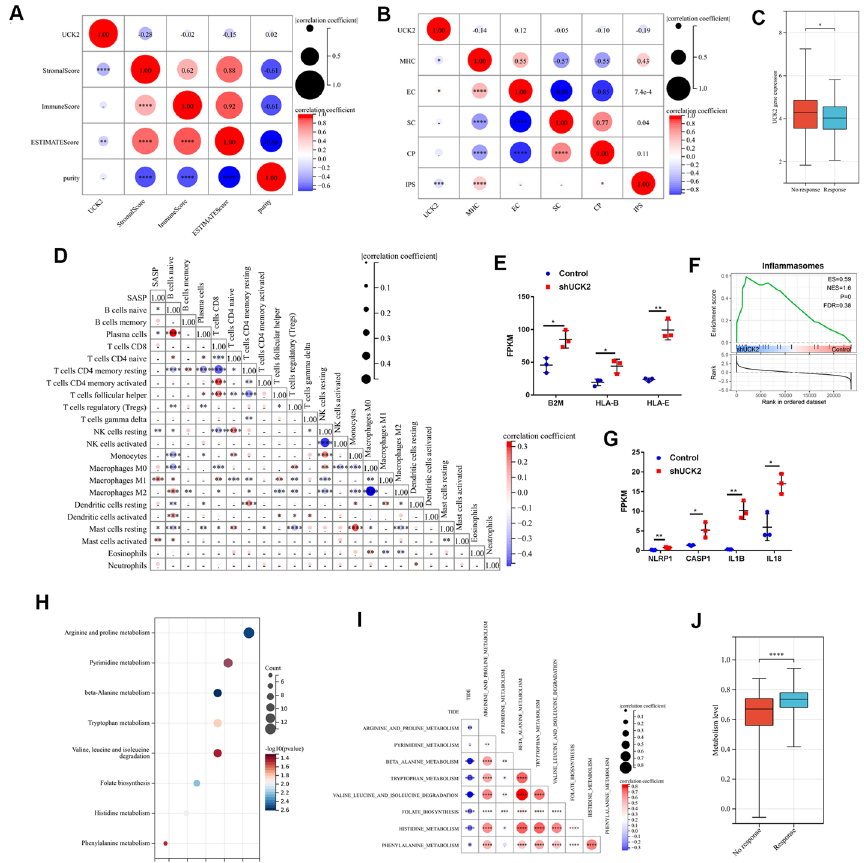
Fig. 7 Targeting UCK2 could enhance the sensitive of tumour cell to T-cell-mediated killing. A Correlation of UCK2 with ESTIMATE scores and tumour purity. B Correlation between UCK2 and IPS scores. C Gene expression of UCK2 in immunotherapeutic response versus non-response group from TIDE. D Correlation between SASP and immune cell infiltrating derived from CIBFERSORT. E Gene expression of B2M, HLA-B and HLA-E in the indicated cell lines. F GSEA revealed the level of inflammasomes in the indicated cell lines. G Gene expression of NLRP1, CASP1, IL1B and IL18 in the indicated cell lines. H Different expression genes enriched in KEGG signalling pathways. I Correlation between TIDE score and metabolism related signalling pathways. J Downregulated UCK2 induced metabolism altered in immunotherapeutic response versus non-response group from TIDE; * p < 0.05; ** p < 0.01; *** p < 0.001; **** p <